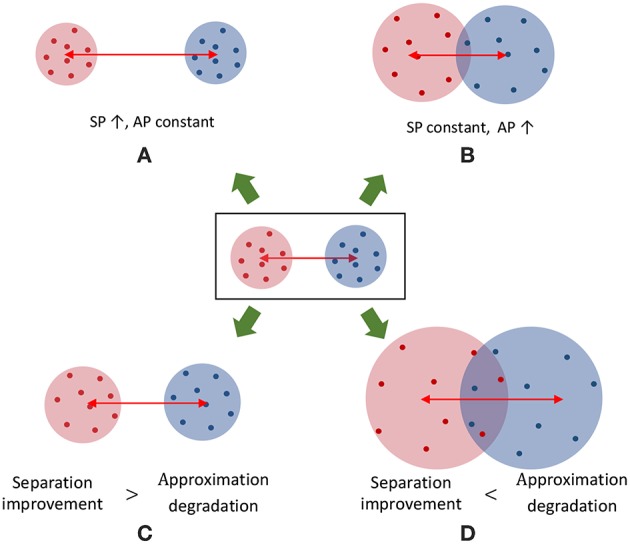
A cartoon that shows the distribution of two dimensional data points that belong to two classes under different conditions. (A) A case with increased SP while maintaining the same AP. (B) A case where the AP is increased while maintaining the same SP. Note that the class boundaries can get overlapped leading to classification errors. Hence, increased AP is not desirable. (C,D) shows two scenarios where both SP and AP increased from the baseline distribution of data points (figure in the middle). (C) The improvement in SP is larger than the degradation in AP. (D) The improvement in SP is not sufficient to compensate for the AP degradation, leading to overlapped class boundaries.